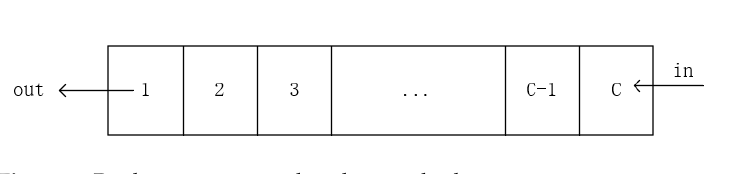
Figure 8. Replay memory pool update method.